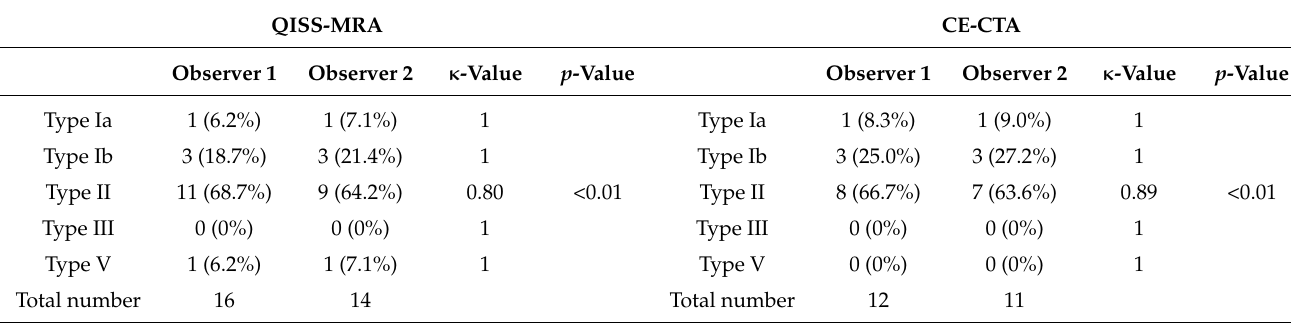
Table 3. Modality-specific interobserver